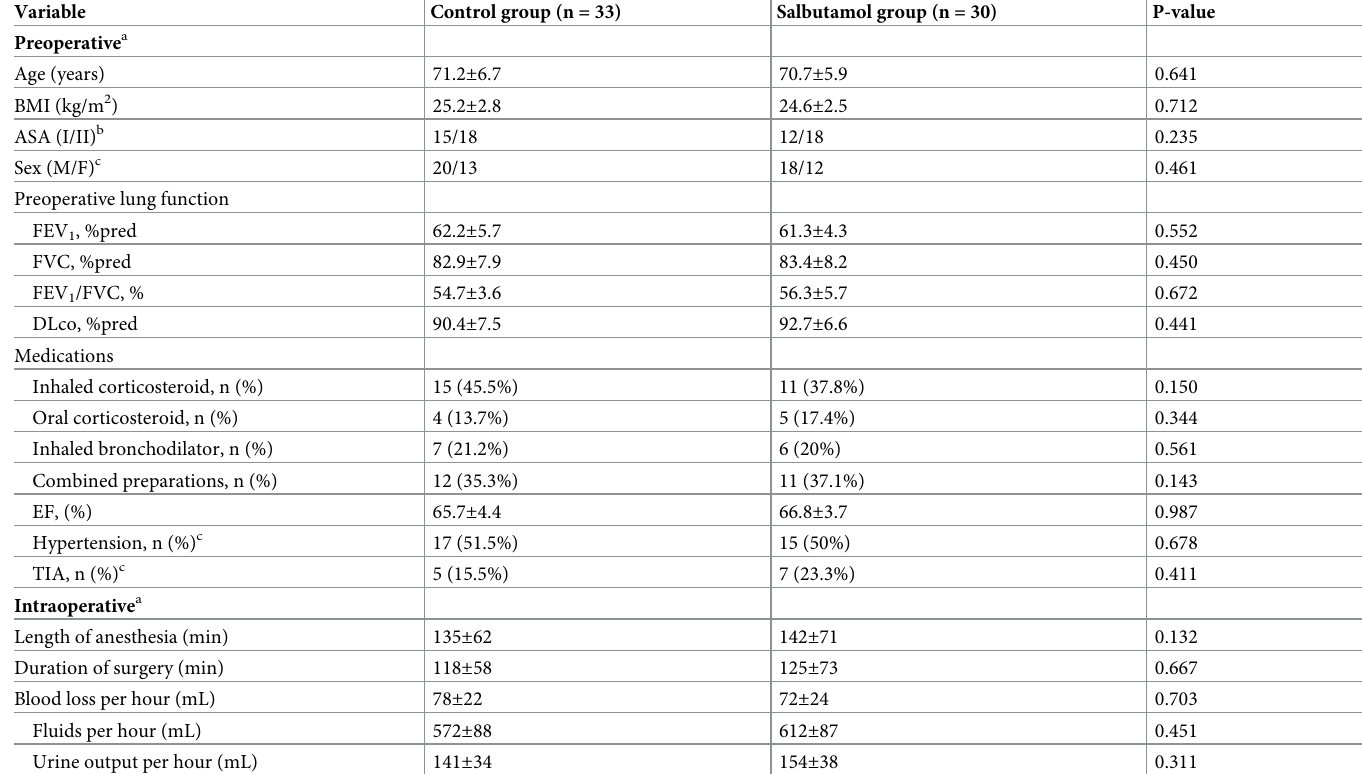
Table 1. Baseline characteristics and operative data of the